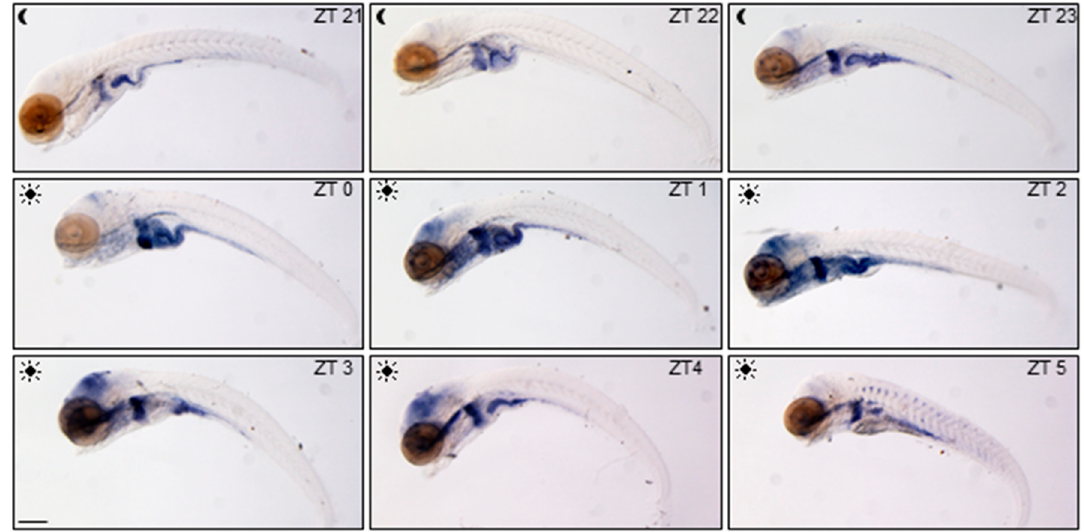
Figure 1. Spatial and temporal variations of glucocorticoid activity. WMISH of egfp mRNA in 5-dpf ia20 larvae exposed to standard photoperiodic regime and analyzed from 3 h before to 5 h after light onset (from ZT21 to ZT5). All larvae are lateral views with head pointing to the left. Scale bar: 200 μ M.